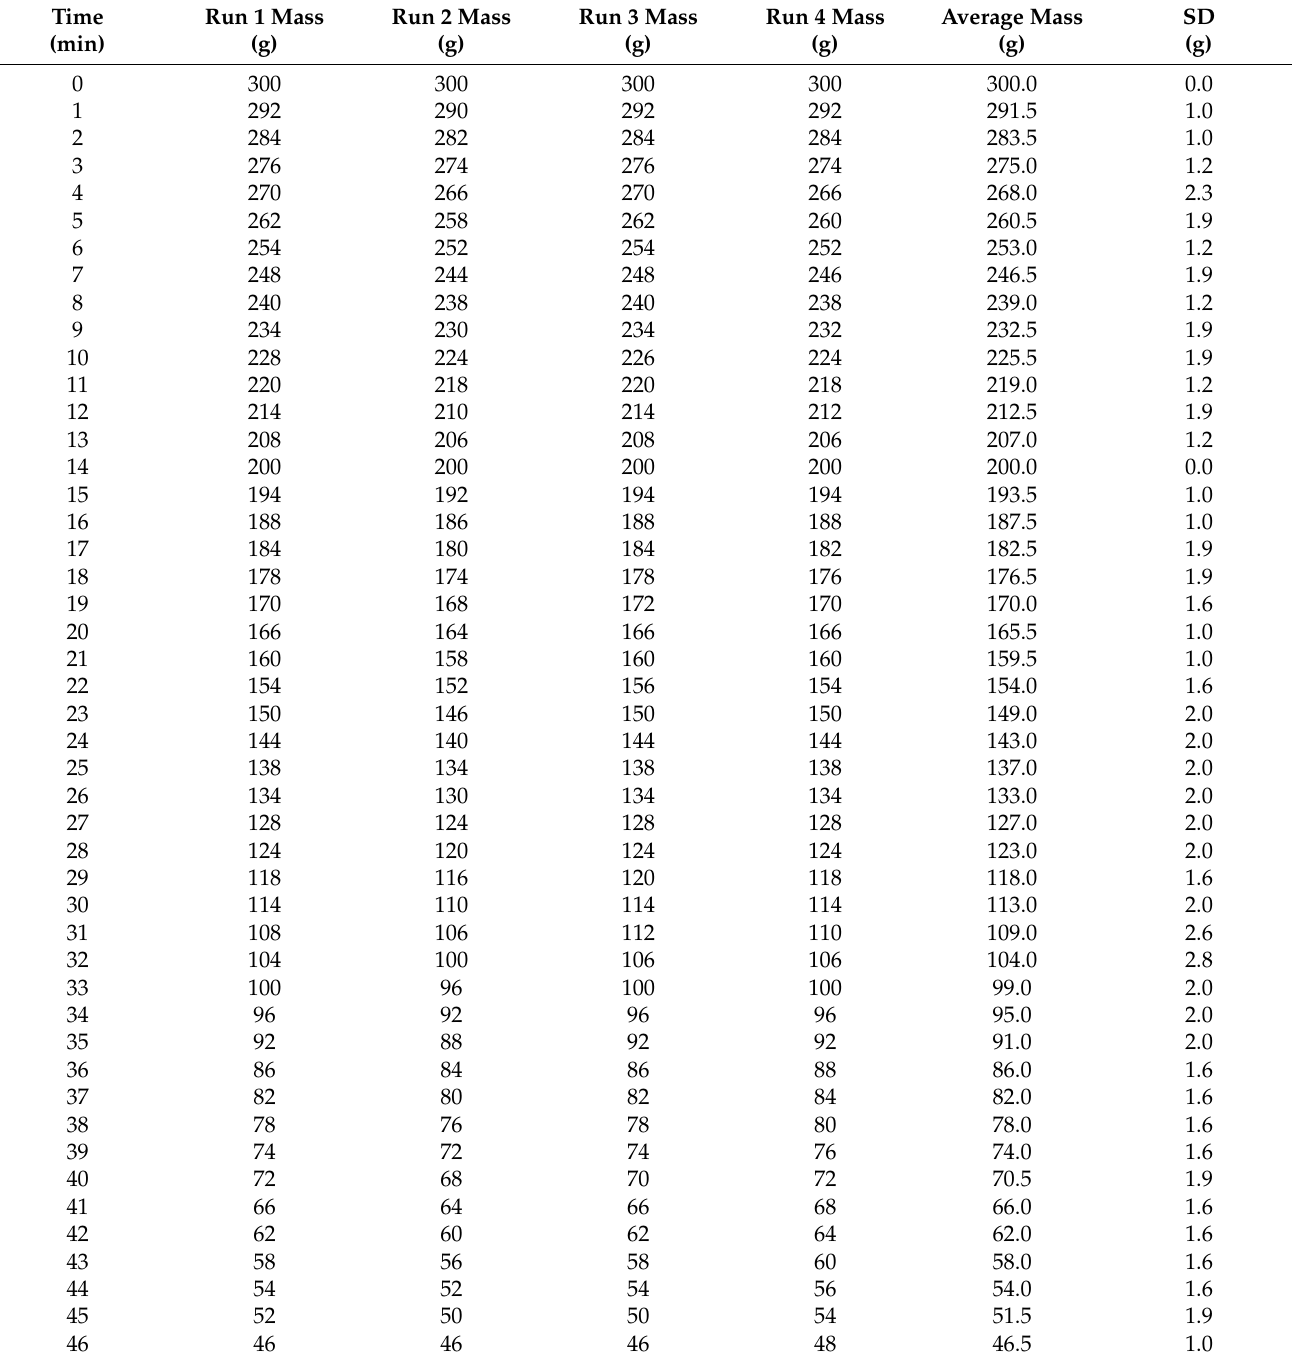
Table A5. Configuration E mass